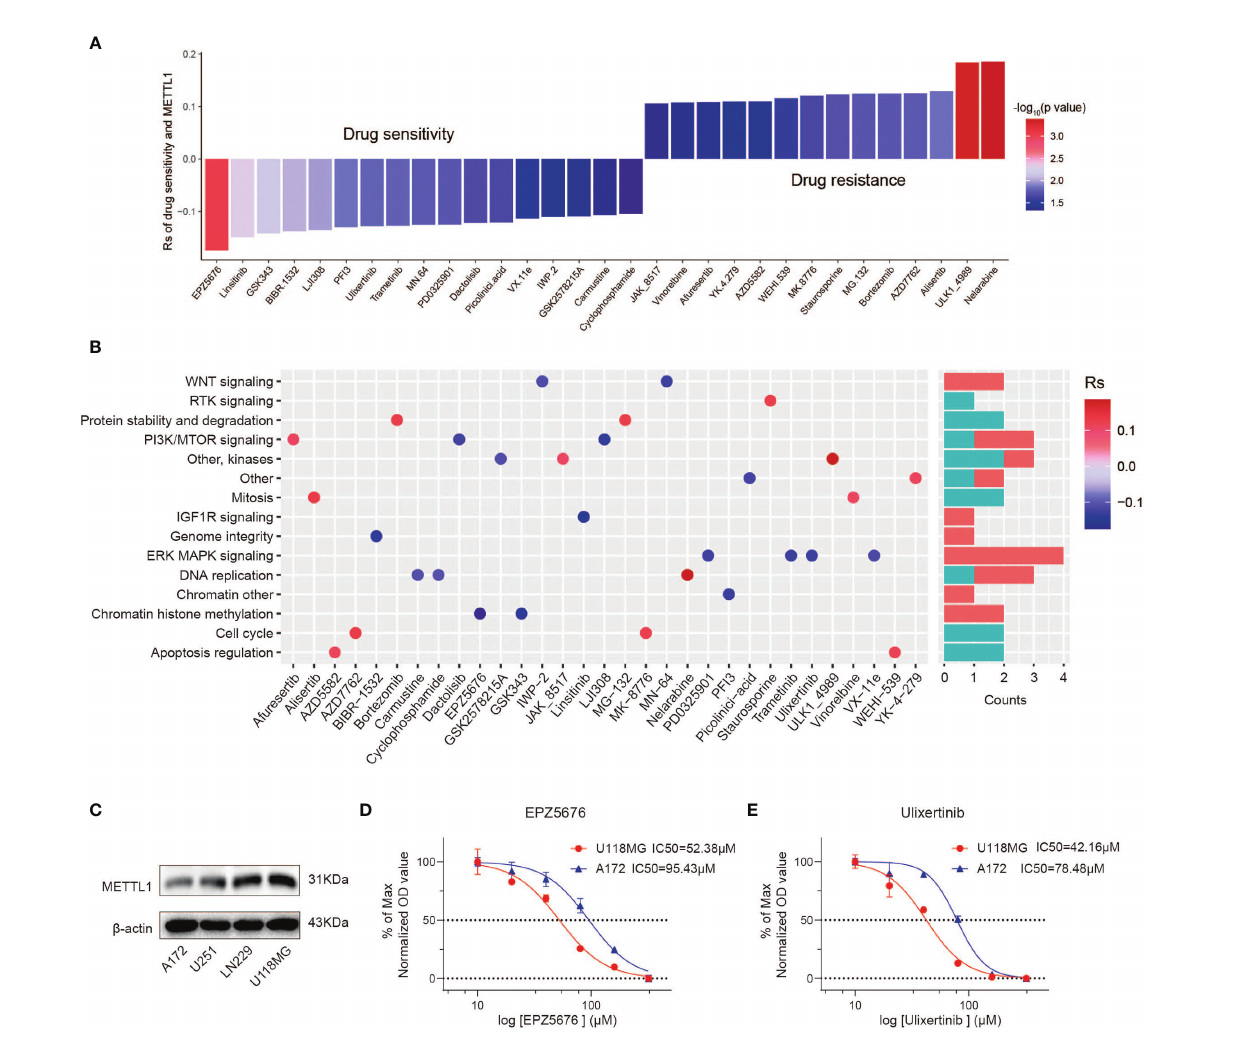
FIGURE 8 | The relationship between METTL1 expression and response to drug sensitivity. (A) The relationship between METTL1 expression and drug sensitivity calculated by Spearman algorithm. The color of each column represents the p value, whereas the height of each column represents the correlation coef fi cient. Rs represents the drug sensitivity correlated with the METTL1 expression. (B) Dot plot visualized the signal pathways targeted by drugs which were sensitivity (blue) or resistant (red) to the METTL1 expression. The bar plot on the right represented drugs ’ number of each targeted pathway. (C) Western blot analysis was performed to assess the expression levels of METTL1 in four glioma cell lines. (D, E) Representative EPZ5676 and Ulixertinib dose response curves of U118MG and A172 assessed by CCK-8 assay at 24 h